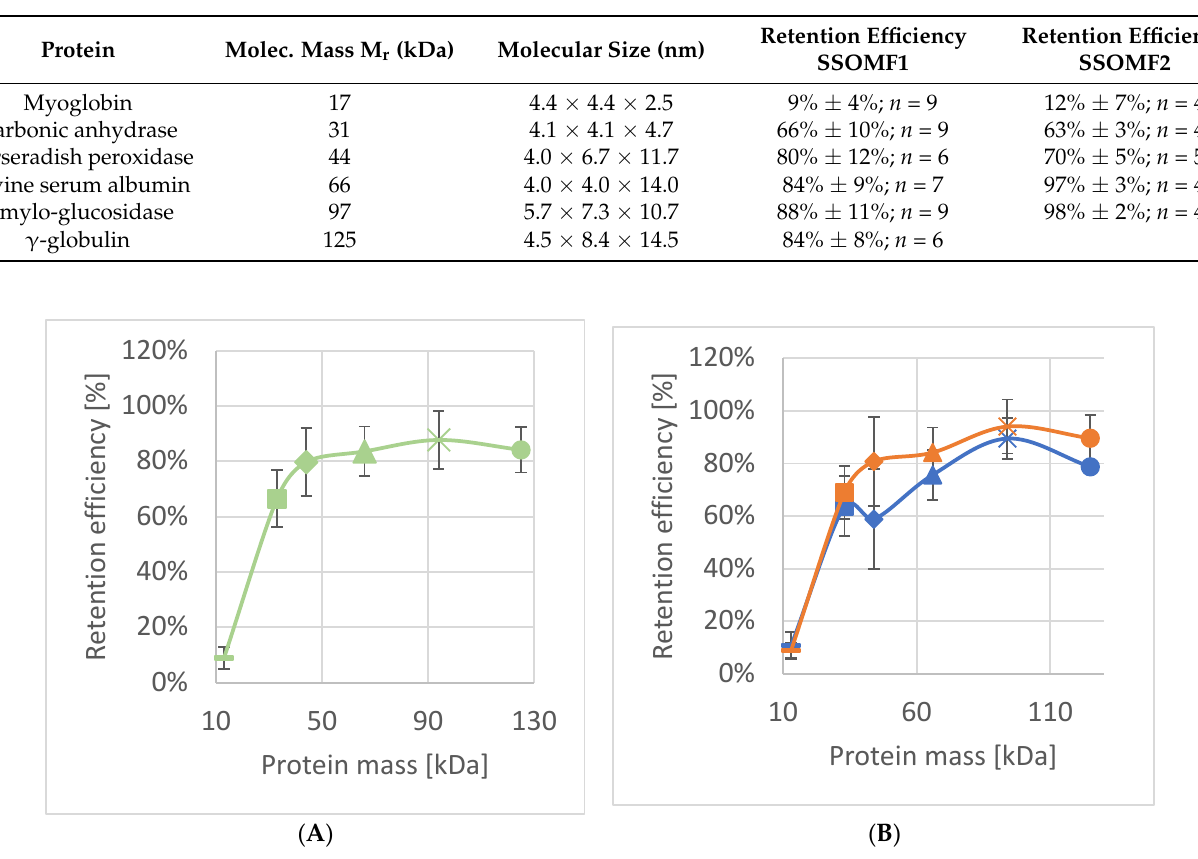
Figure 4. ( A ) Average efficiency of Saccharolobus solfataricus P2 fragments deposited on microfilter 1 (SSOMF1) across all experiments ( n ≥ 6); ( B ) retention efficiency of SSOMF1 where Orange= filtration sequence largest to smallest protein ( n ≥ 3) and Blue = filtration sequence smallest to largest protein ( n ≥ 3); Legend for A and B: ▬ = myoglobin (17 kDa); ■ = carbonic anhydrase (31 kDa); ♦ = horseradish peroxidase (44 kDa); ▲ = bovine serum albumin (66 kDa); x = amyloglucosidase (97 kDa) and ● = γ -globulin (125 kDa).